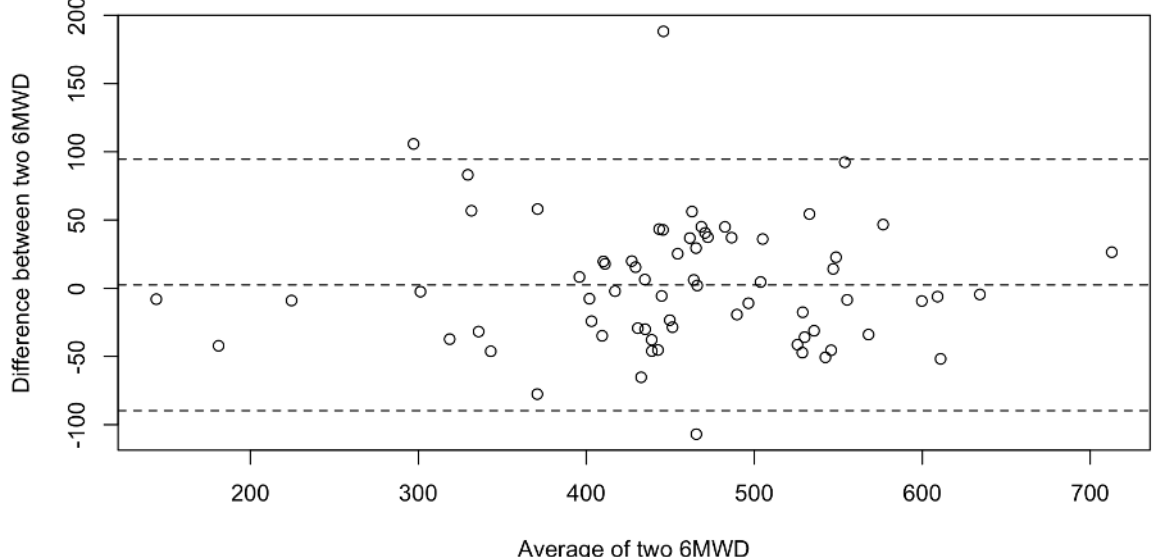
Figure 4. Bland-Altman plot of the difference between the 6-minute walk test distance as observed by the physiologist during a 6-minute walk test in clinic and as measured by the app in outdoor mode within 7 days of the clinic test. 6MWD: 6-minute walk test